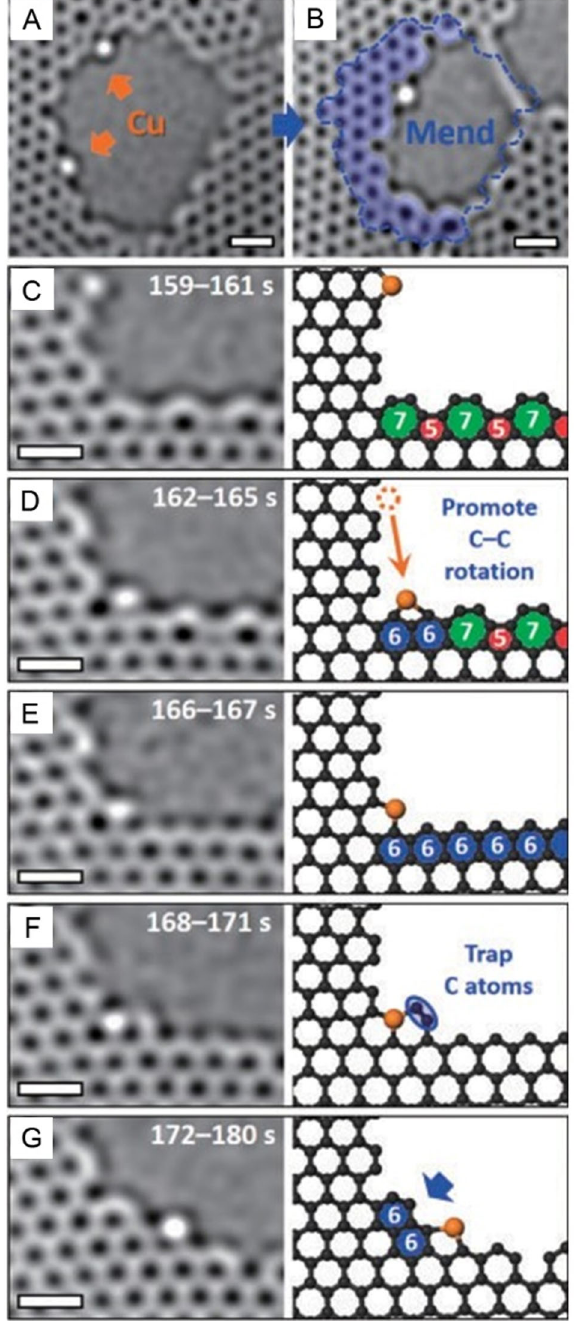
Fig. 6 Cu atom behavior at graphene edges. A TEM image of two Cu atoms at the graphene edge. B TEM image taken ∼ 3 min after ( A ). C – G TEM images and schematic atomic models showing the Cu- mediated mending of the graphene edge. All of these TEM images were extracted from Movie S1 in the online supplementary data at http://stacks.iop.org/APEX/10/025104/mmedia, where ( A ) corre- sponds to t = 0 s. Scale bars represent 0.5 nm. Reproduced with permission from the Japan Society of Applied Physics 46